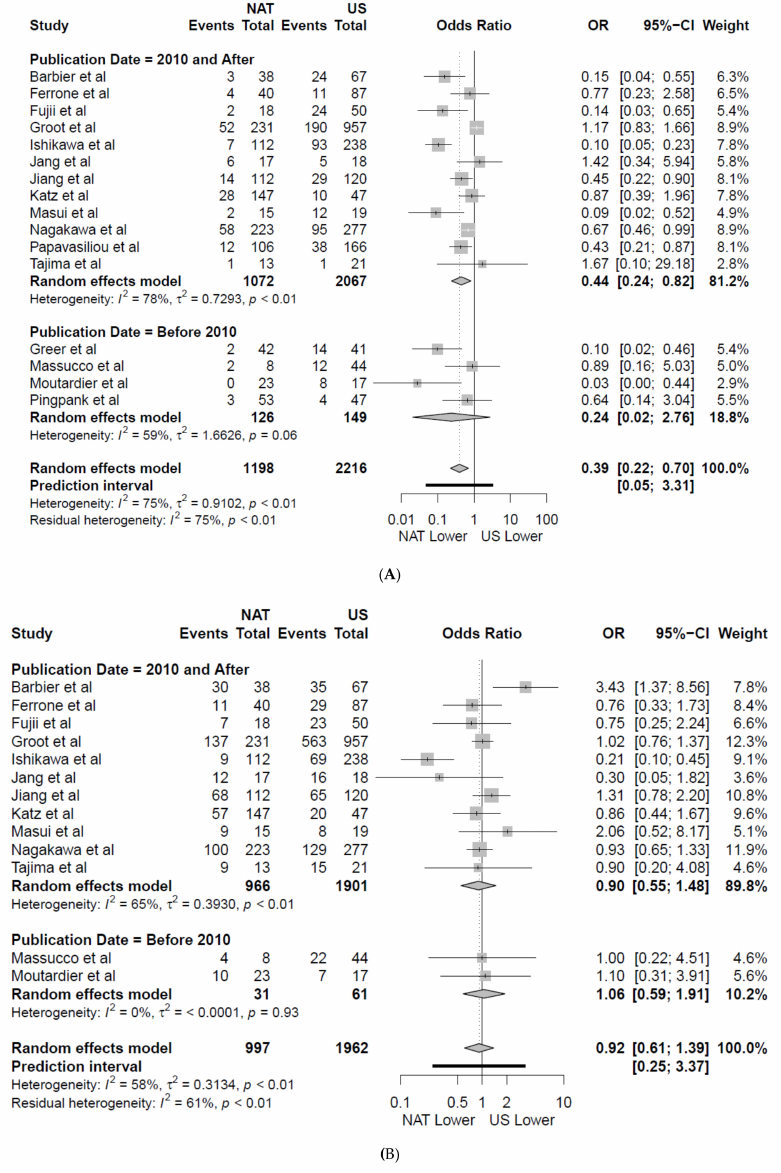
Figure 4. Forest plot showing: ( A ) locoregional ( n ) and ( B ) distal recurrence rates ( n ) following neoadjuvant therapy (NAT) vs. up-front Surgery (US). The results of a subgroup analysis of all articles published after 2010 are also shown. A Manel–Haenszel random e ff ects model with a Hartung–Knapp adjustment was used for the meta-analysis of all outcomes. A Sidik–Jonkman estimator was utilised for tau 2 . Odds ratios (OR) are shown with 95 percent confidence intervals